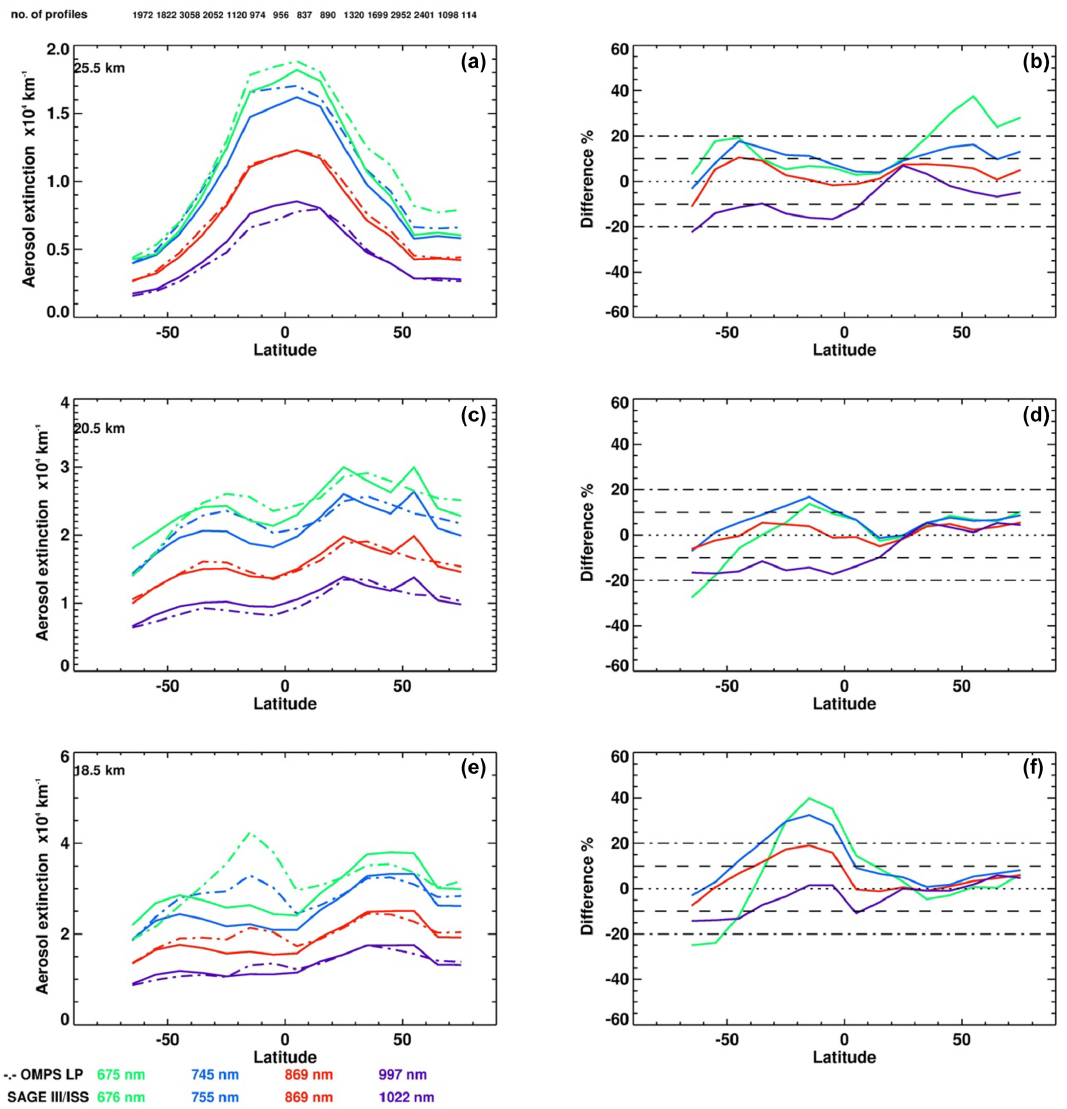
Figure 5. Panels (a) , (c) and (e) are OMPS v2.0 (dash) and SAGE III (solid) aerosol extinction coefficient ( × 10 4 km − 1 ) at 25.5, 20.5 and 18.5km, for 675 (green), 745 (blue), 869 (red) and 997nm (violet). Panels (b) , (d) and (f) are the percent difference between the two measurements. The number of coincidences for each zone is shown in the left top